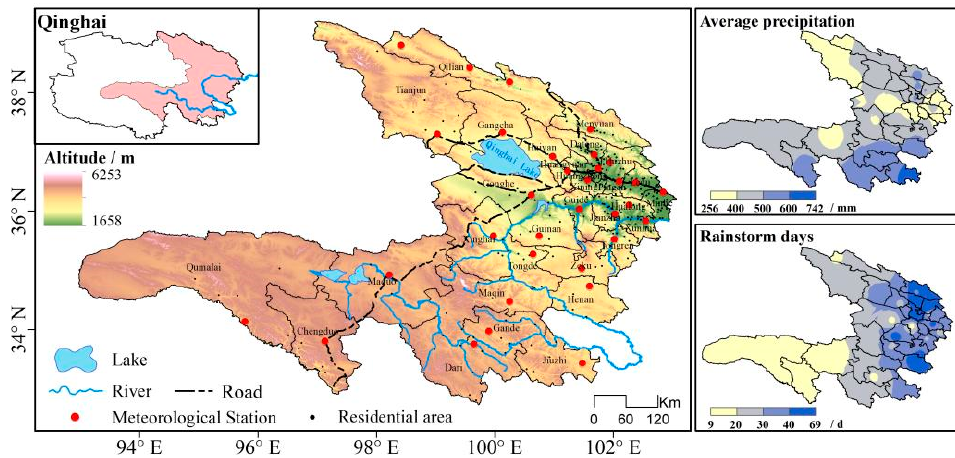
Figure 1. Map of the location of the upper Yellow River